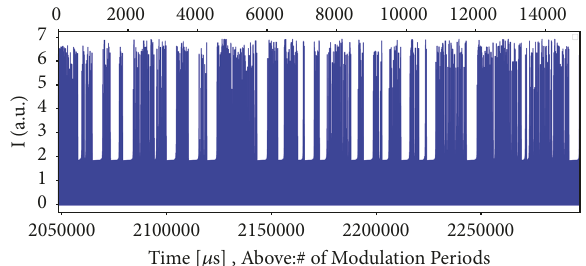
Figure 2: Intensity, I, as a function of time measured in units of the modulation period for a modulation amplitude 𝑚 = 3.8874 10 −2 , and Δ𝜙 0 = −6 10 −2 . All other control parameter values are the same to those of Figure